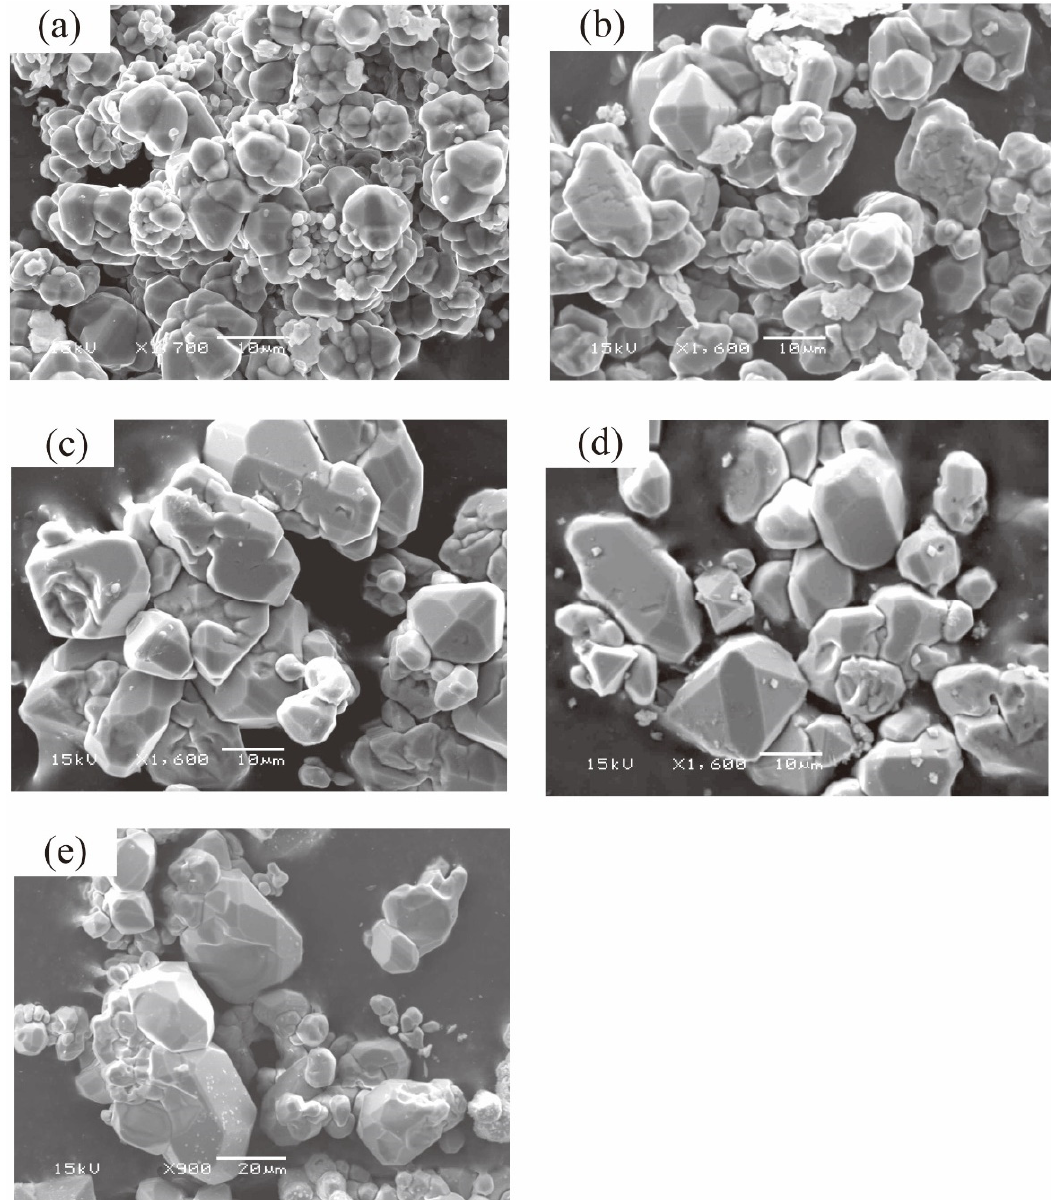
Figure 2. SEM images of solid run products at 700 °C and 100 MPa: ( a ) Fo 100 -2, ( b ) Fo 75 Fa 25 -7, ( c ) Fo 50 Fa 50 -3, ( d ) Fo 25 Fa 75 -2, and ( e ) Fa 100 -6.